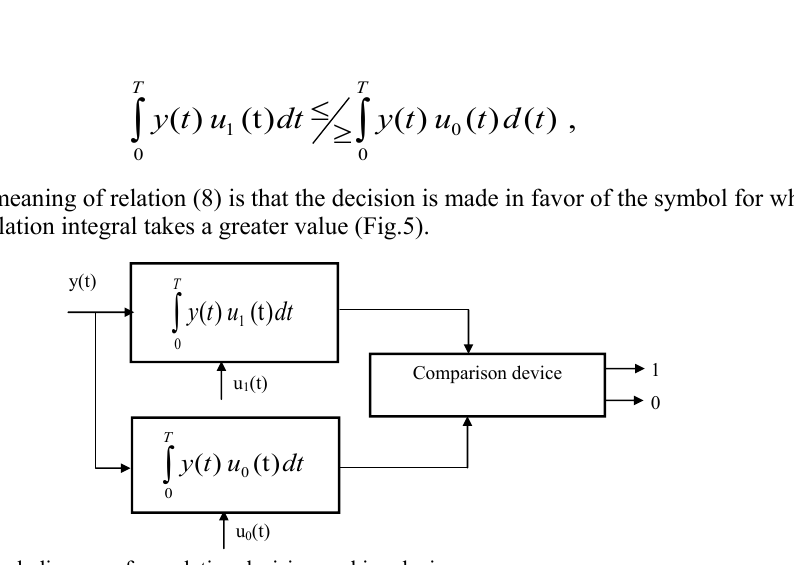
Fig. 5. Block diagram of correlation decision-making device.